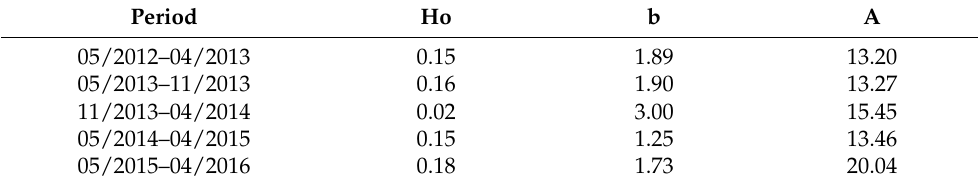
Figure 9. Jiboa Catchment. ( A ) Boundaries and rainfall gauge, ( B ) the spatial model setup, where the lake and the upstream area ‘Lake subcatchment’ are represented separately using HBV lumped model and the representation of the rest of the catchment changes from lumped to distributed with different spatial resolutions. Table 2. Discharge rating curve coefficients for Puente Viejo